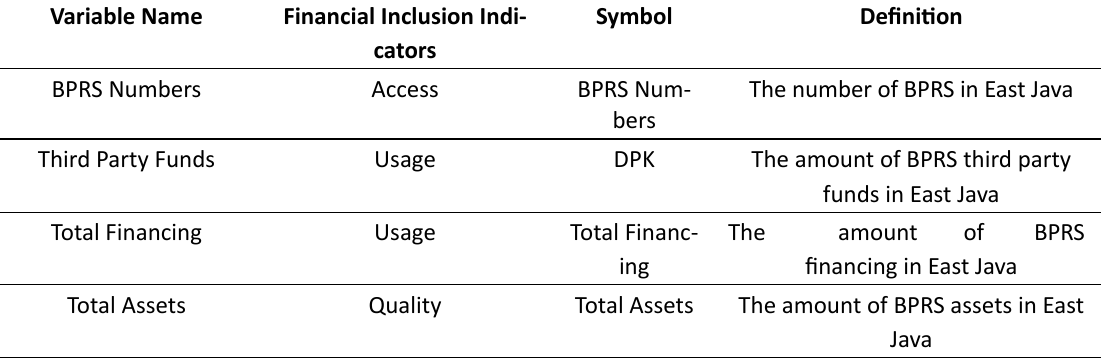
Table 2: Definition of Research